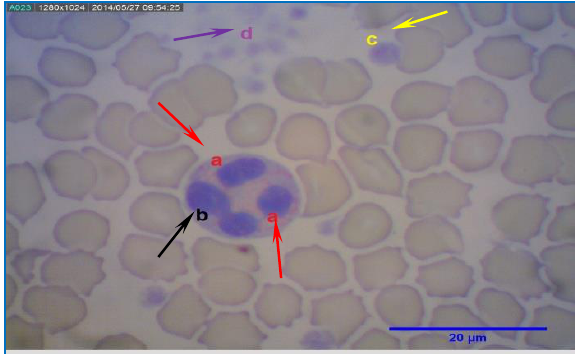
Figure, 4: Neutrophil with four lobes with (a) two thin threads, (b) thick thread, (c) large-sized blood platelet, (d) Aggregation of blood platelets (100x × 1.3 megapixels).